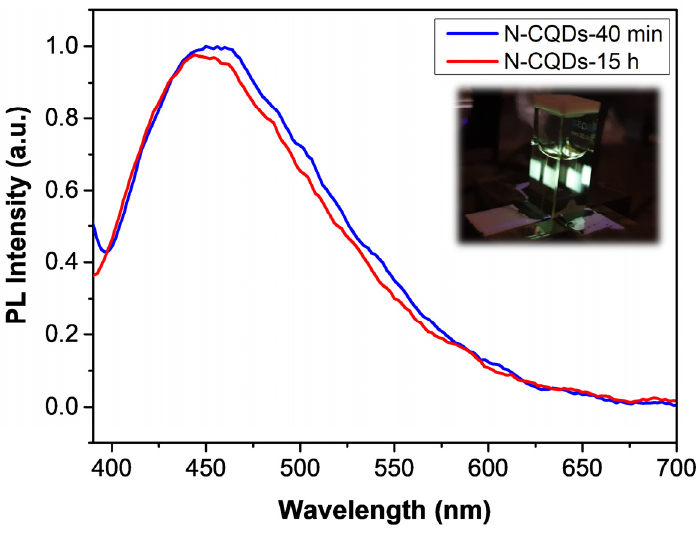
Figure 5. Normalized photoluminescent spectra of N-CQDs-40 min (blue solid line) and N-CQDs- 15 h (red solid line). Inset: photograph of the N-CQDs solution excited at 360 nm.